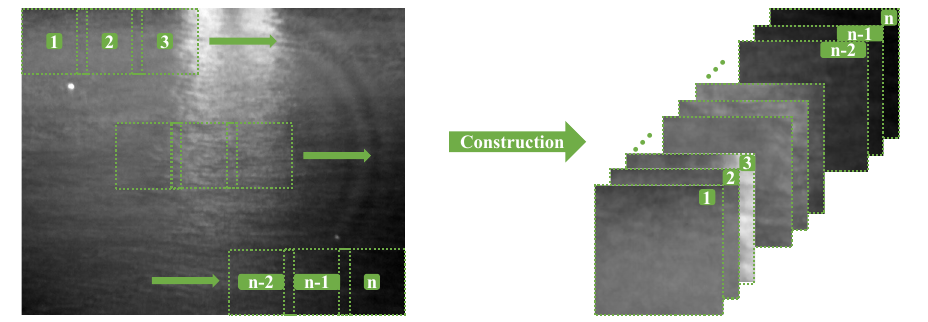
Figure 4. The construction of